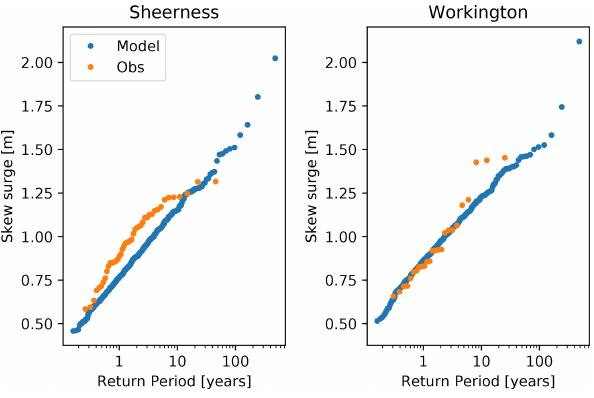
Figure 1. Empirical return level plots of skew surge, comparing simulated and observational (tide gauge) data at Sheerness and